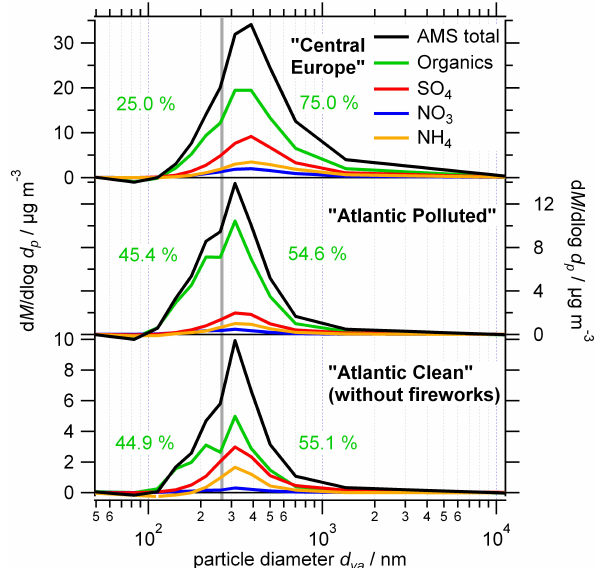
Fig. 8. AMS median mass size distributions for different air masses, measured at Sub NE. For the “Atlantic Clean” air masses size dis- tributions, time periods influenced by fireworks were excluded. For organics size distributions, only m/z ’s up to m/z 100 were used to reduce noise. The “AMS total” is the sum of the species shown. Chloride showed no significant signal during any of the air masses. The AMS size distributions shown are scaled to the median of the measured mass concentrations for the respective time period and species. Given in the graph (green numbers) are the mass con- tributions to the total organics from particles in the size range d va ≤ 259nm (left) and d va > 259nm (right). The size of 259nm d va is marked with a grey vertical